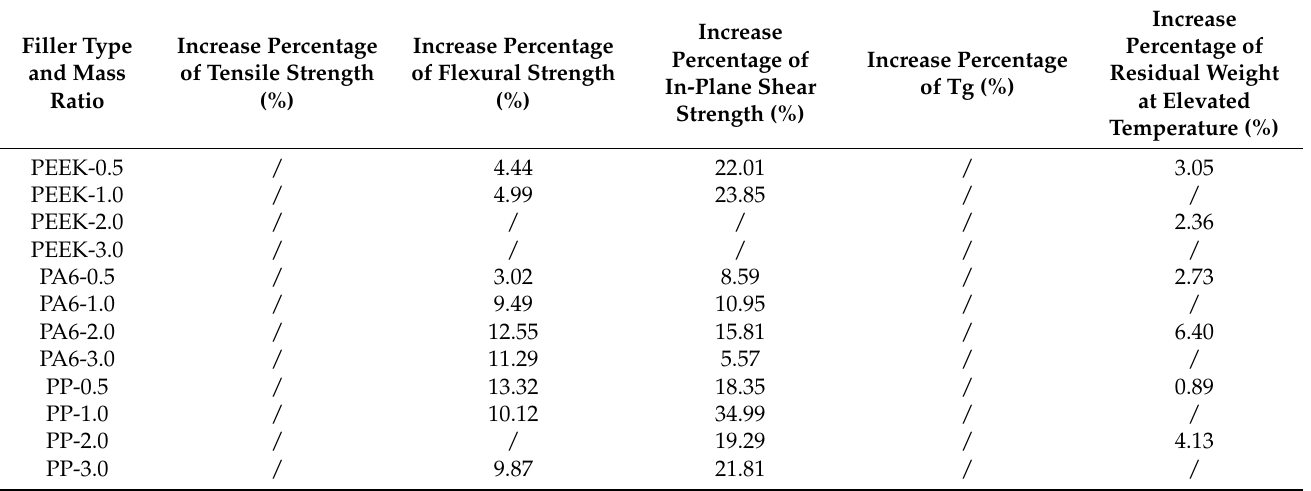
Table 3. Proportioning design of optimal resin filler and the improvement percentage of mechanical and thermal properties.